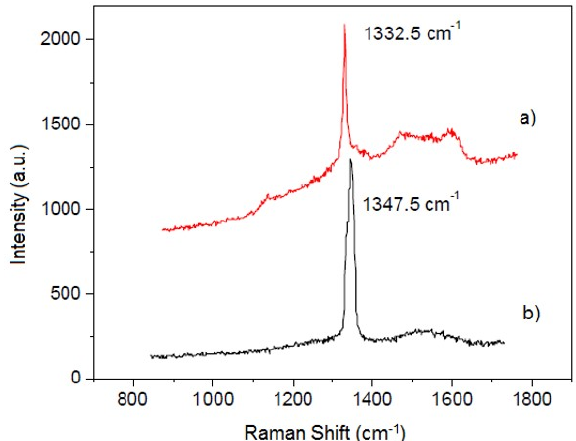
Figure 5. The Raman spectra (excitation with laser at 514.5 nm) for diamond deposited on FeB boride layer. ( a ) On a delaminated diamond piece; ( b ) On a diamond piece adhered to the surface.